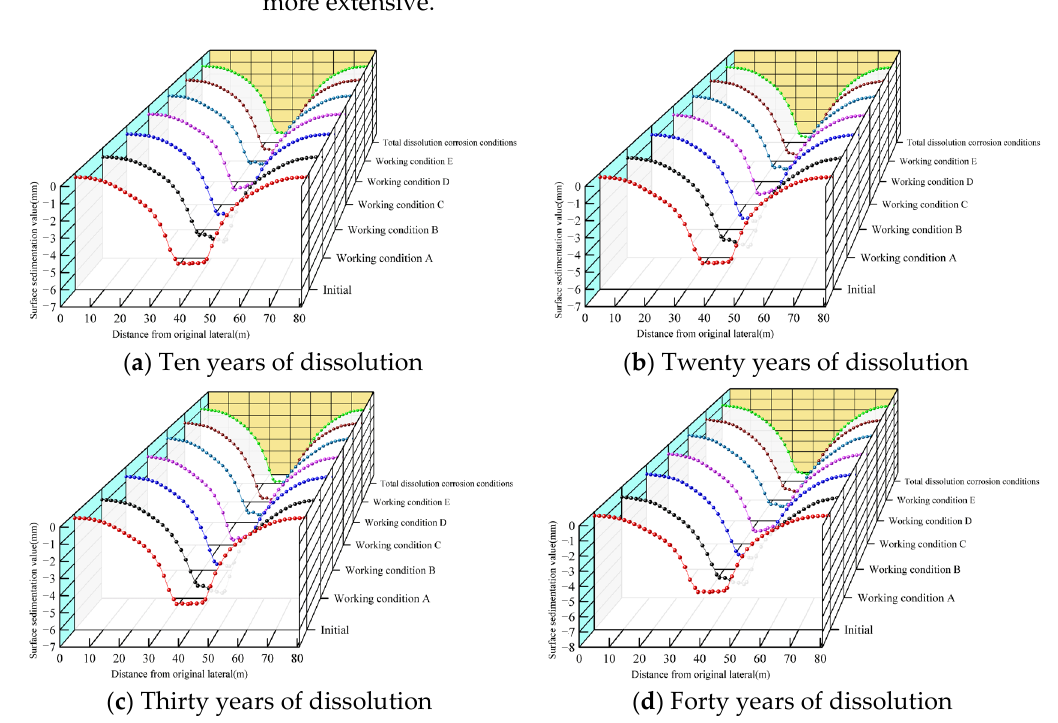
Figure 14. Comparison of surface longitudinal settlement curve patterns caused by dissolution degradation at different locations and shown for a given time.